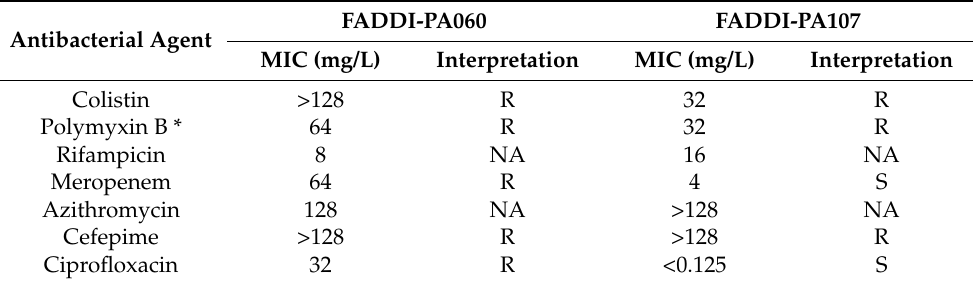
Table 1. Minimum inhibitory concentrations (MICs).